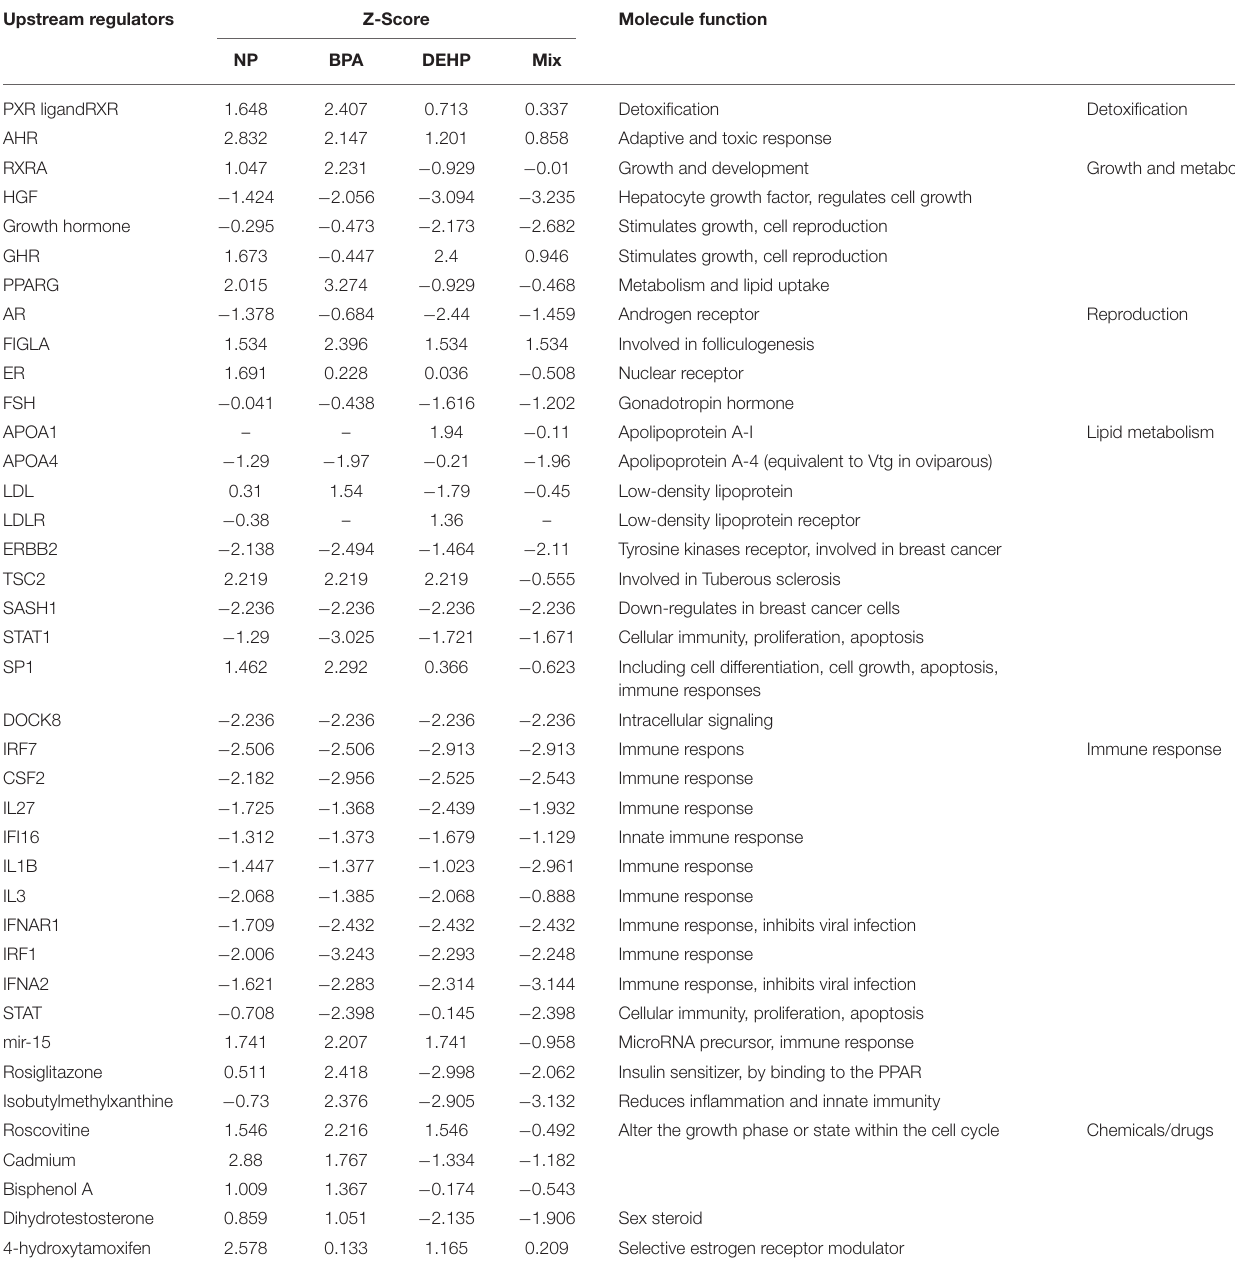
TABLE 4 | Predicted master regulators that might be associated with observed dysregulation in the male fathead minnow liver following exposure to NP, BPA, DEHP and the mixture of three compounds for 21 days. Upstream